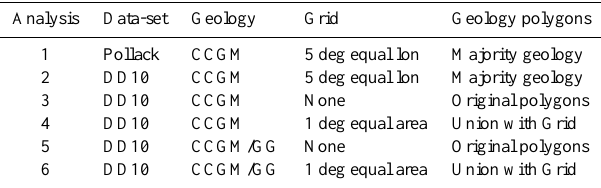
Table 4. Description of the various analyses undertaken. 5 deg eq lon; a grid with 5 degree spacing in longitude. 1 deg eq area; a grid with 1 degree spacing in longitude at the equator, but varying longi- tude at other latitudes to maintain an equal area. Majority Geology; the geology which takes up the greatest area inside the grid cell is ascribed to the whole grid cell. These and other aspects related to this table, including union, are described further in the